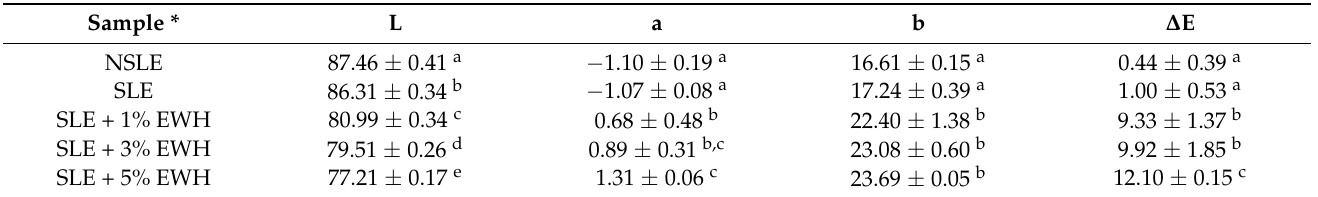
Table 4. Color analysis of non-sterilized liquid egg white (NSLE), sterilized liquid egg white (SLE), and SLE supplemented with 1%, 3%, or 5% egg white hydrolysate (EWH).